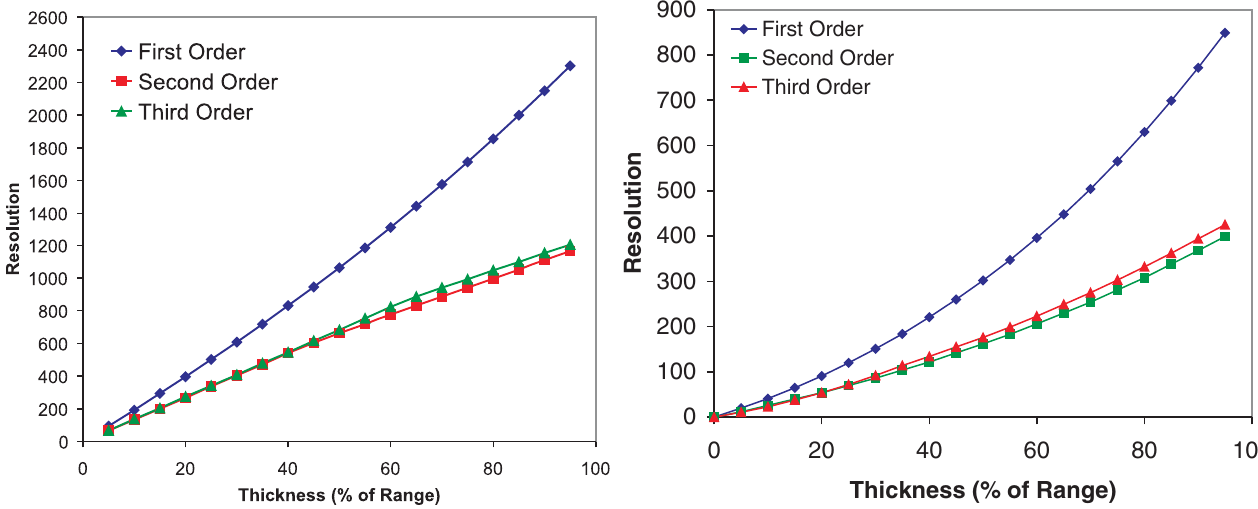
FIG. 11. (Color) Mass (left) and charge (right) resolving powers for a 400 MeV = u 132 Sn beam and Al wedge as a function of wedge thickness evaluated at different map